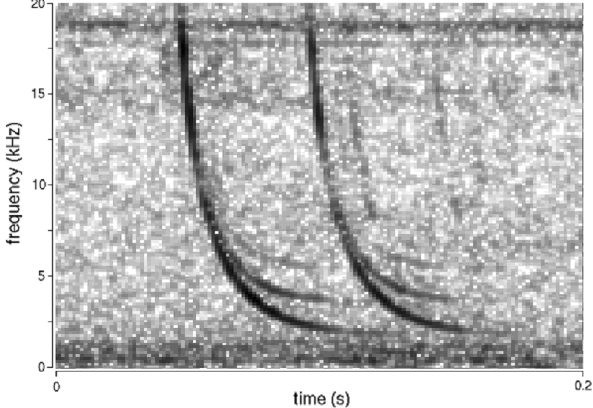
Fig. 4. Series of the lowest (transversal electromagnetic mode, TEM) and the first mode pattern on short-path fractional-hop whistlers without higher modes, seen in the ICE electric field data of the DEMETER satellite (orbit: 1430 up, sensor: E34, date: 8 Oc- tober 2004, 19:48:49.3 UT, satellite position: 40.9N; 29E, altitude: 713.0, L: 1.73).